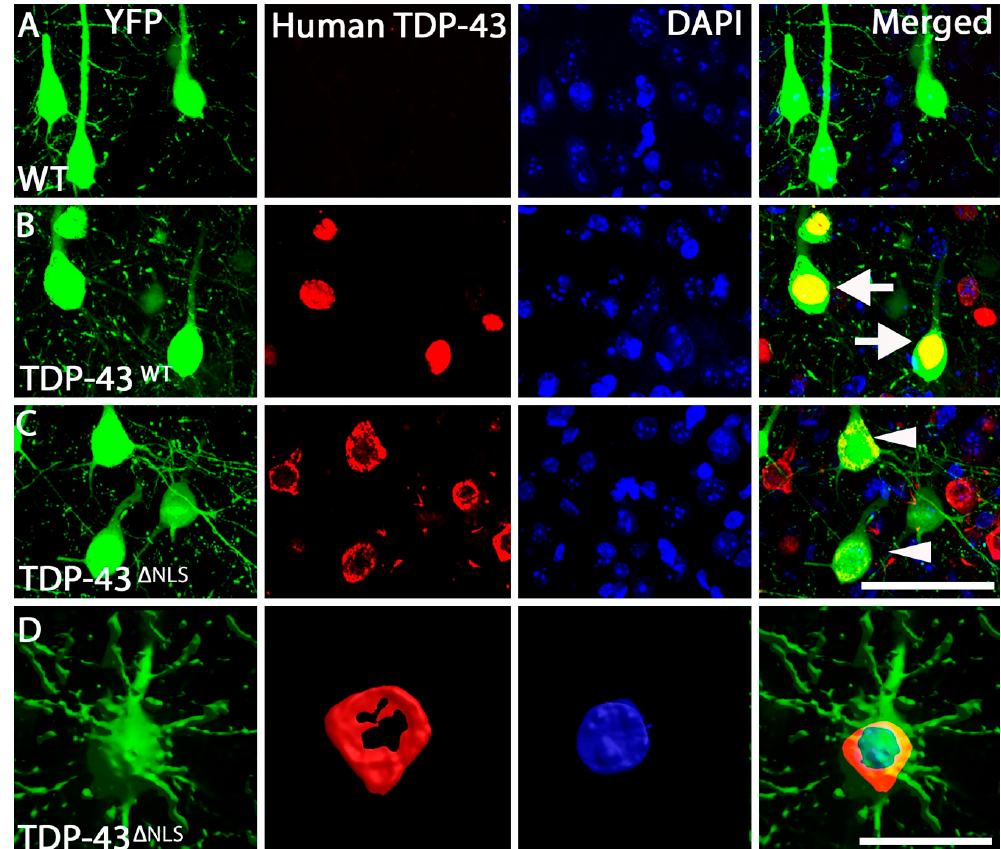
Figure 2. TDP-43 localization within the motor cortex. ( A ). Example of WT Layer V neurons within the motor cortex that are positive for YFP (green) and DAPI (blue), with no human TDP-43 (red) labelling present. ( B ). TDP-43 WT Layer V neurons within the motor cortex were positive for YFP (green), human TDP-43 (red) and DAPI (blue), with human TDP-43 labelling nuclear (arrows) (merged). ( C ). TDP-43 ∆ NLS Layer V neurons within the motor cortex were positive for YFP (green), human TDP-43 (red) and DAPI (blue), with human TDP-43 labelling excluded from the nucleus (arrowheads) (merged). ( D ). Three-dimensional representation of a YFP neuron (green) with TDP-43 (red) wrapping around the DAPI nucleus (blue). Scale bar, A-C = 50 µ m, D = 20 µ